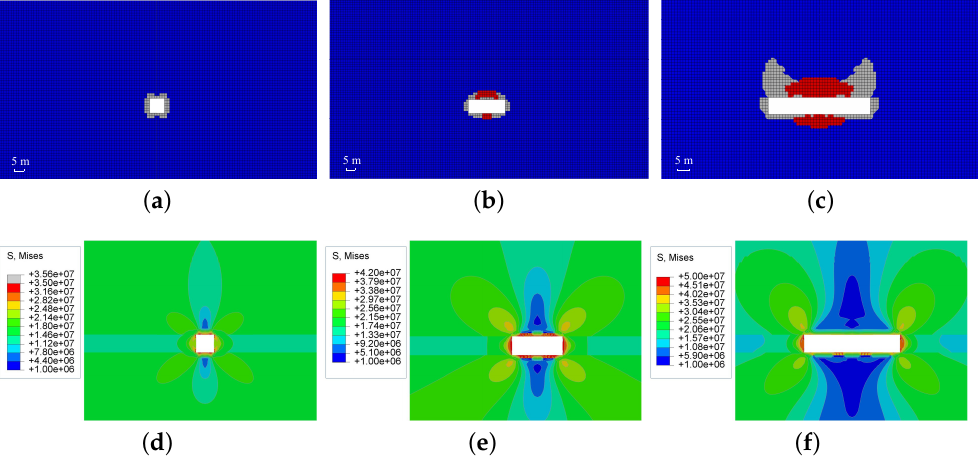
Figure 3. Numerical results of a cavity expansion. ( a ) Broken area (2R = 15 m); ( b ) Broken area (2R = 40 m); ( c ) Broken area (2R = 90 m); ( d ) Mises stress (2R = 15 m); ( e ) Mises stress (2R = 40 m); ( f ) Mises stress (2R = 90